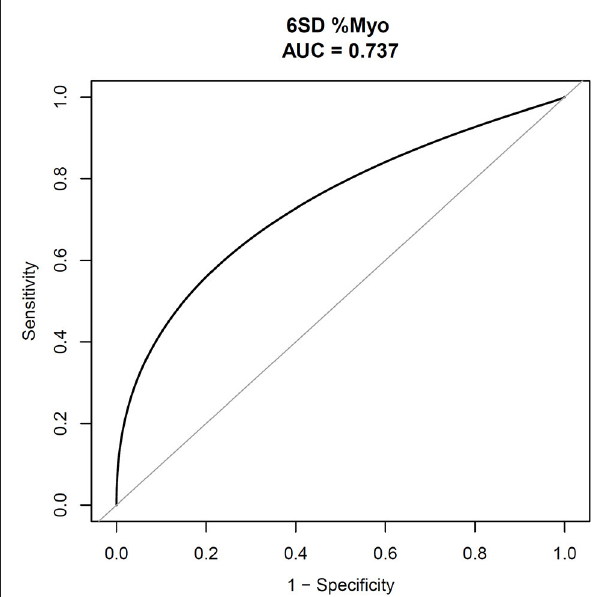
FIGURE 4 | ROC curves for the amount of LGE, using Bootstrap resampling (times = 500) for the association of major adverse cardiac events. AUC confidence interval and significance tests using Bootstrap resampling. The best cut point was based on maximizing the sum of sensitivity and specificity. The analysis reveals that the percentage of LGE by volume of > 10.91%, using the 6-SD method (AUC: 0.74, 95% CI 0.58–0.89; sensitivity: 61.5%; specificity: 85.9%). ROC, receiver-operating characteristic; AUC, area under the curve; SD , standard deviation; CI, confidence